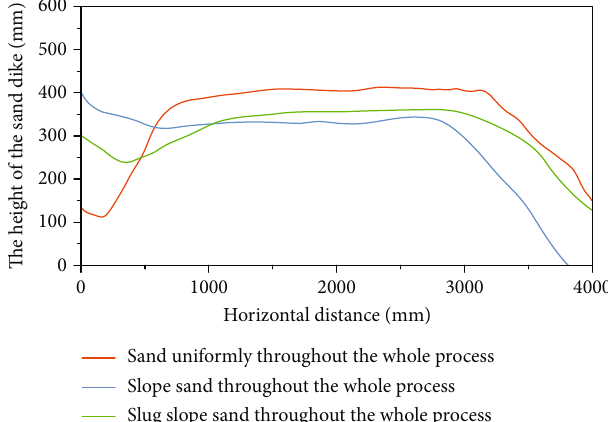
Figure 12: The shape of the sand dike formed by proppant sedimentation in sand carrying by slickwater with di ff erent proppant pumping